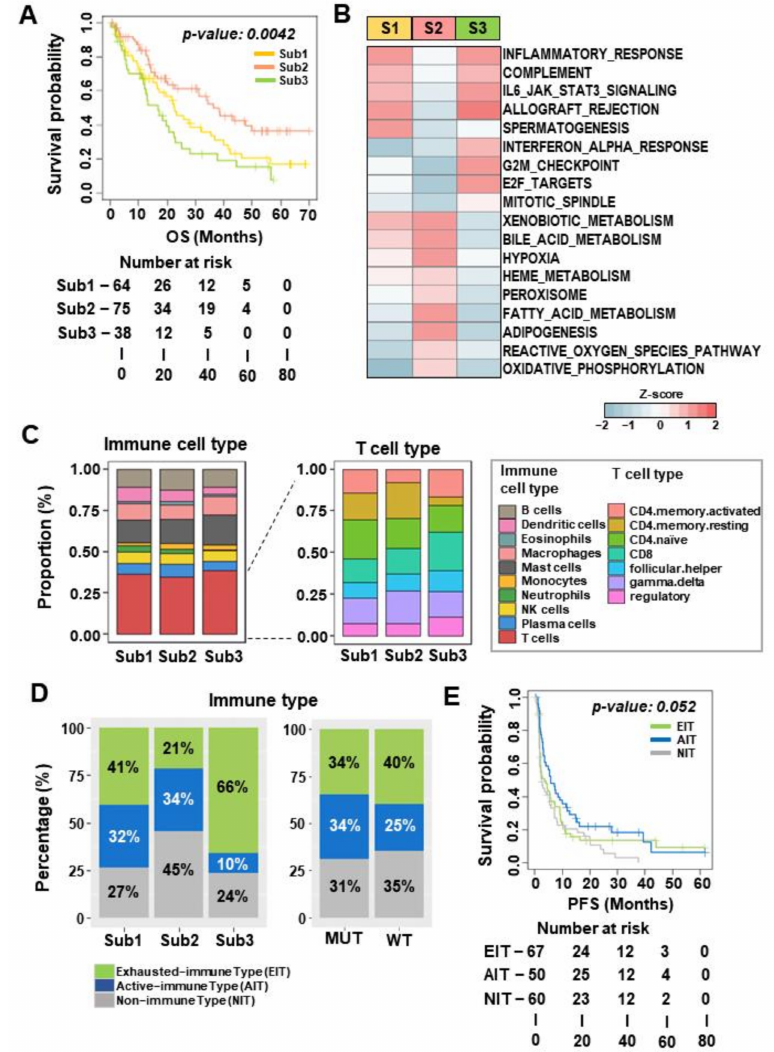
Figure 3. Patients in subtype 2 with enrichment of the PBRM1 mutation are associated with metabolic pathways and transition of immune types. ( A ) Kaplan–Meier plot analysis of the overall survival for each subtype. ( B ) Heatmap of Hallmark gene sets. The mean Z score of the single-sample gene set enrichment analysis for each gene set was calculated (S1, Sub1; S2, Sub2; S3, Sub3). ( C ) CIBERSORTx findings show the proportion of distinct immune cell subpopulations (left) and the proportion of T cell subpopulations (right). ( D ) Barplots show the percentage of immune types, including active immune, exhausted immune and nonimmune types, in each subtype (left) and in the group with PBRM1 mutation vs. the group without PBRM1 mutation (right). ( E ) Kaplan–Meier plot analysis of progression-free survival for each immune type. AIT, active immune type (navy); EIT, exhausted immune type (green); NIT, non-immune type